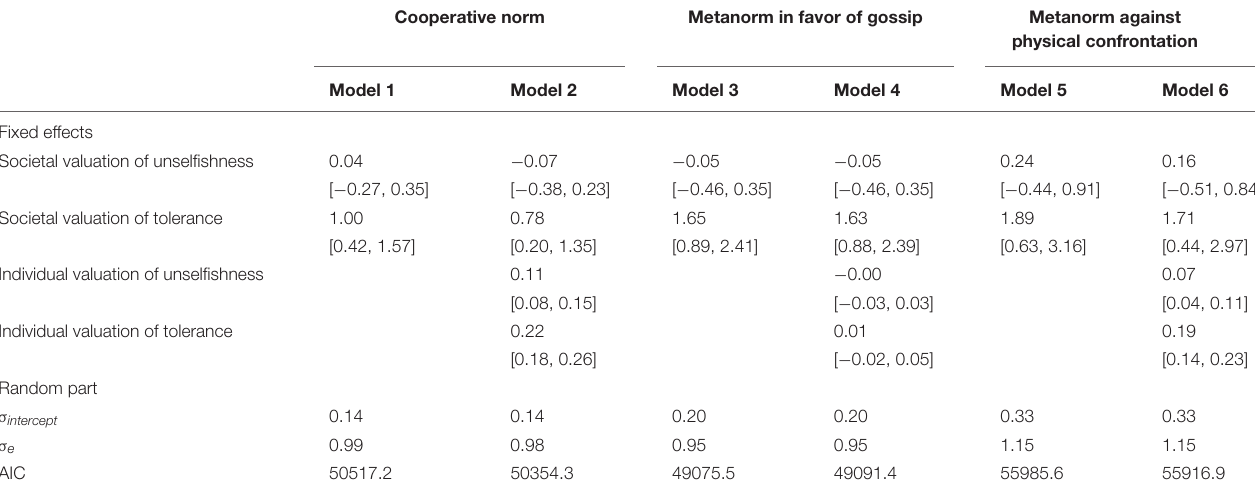
TABLE 5 | Estimates from mixed linear models. Cooperative norm Metanorm in favor of